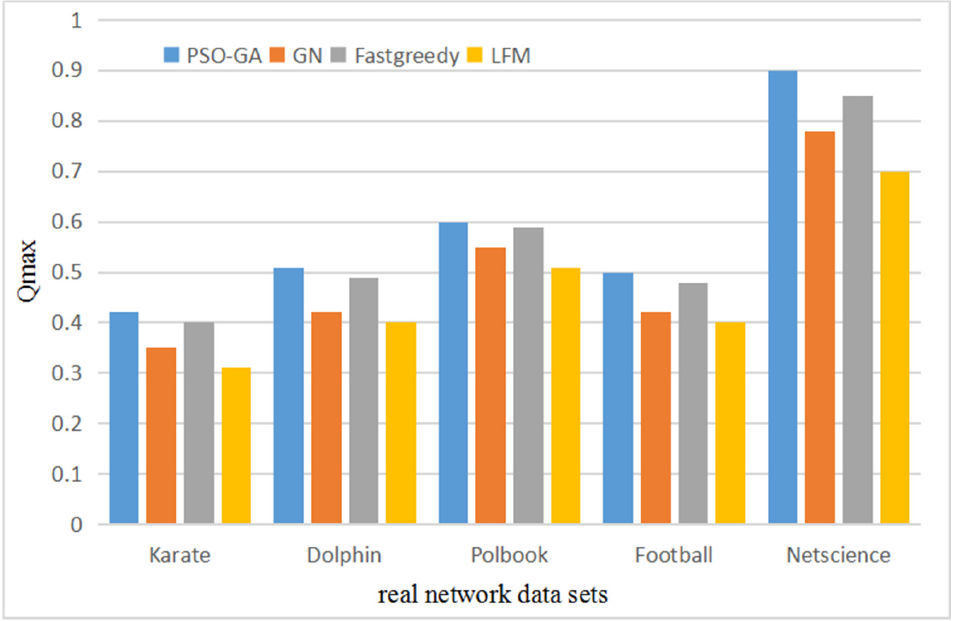
Figure 2. Comparison of results of various algorithms on the real network.